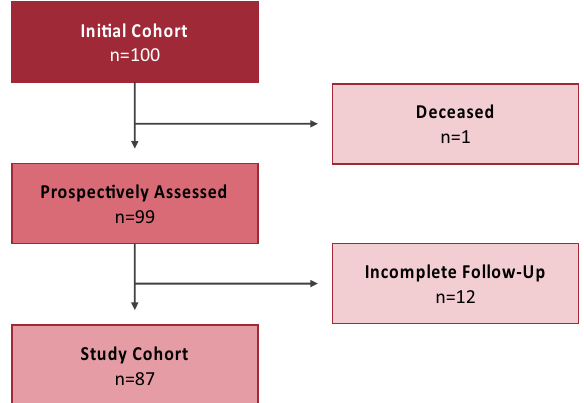
Figure 1. Flow-chart of the study cohort.